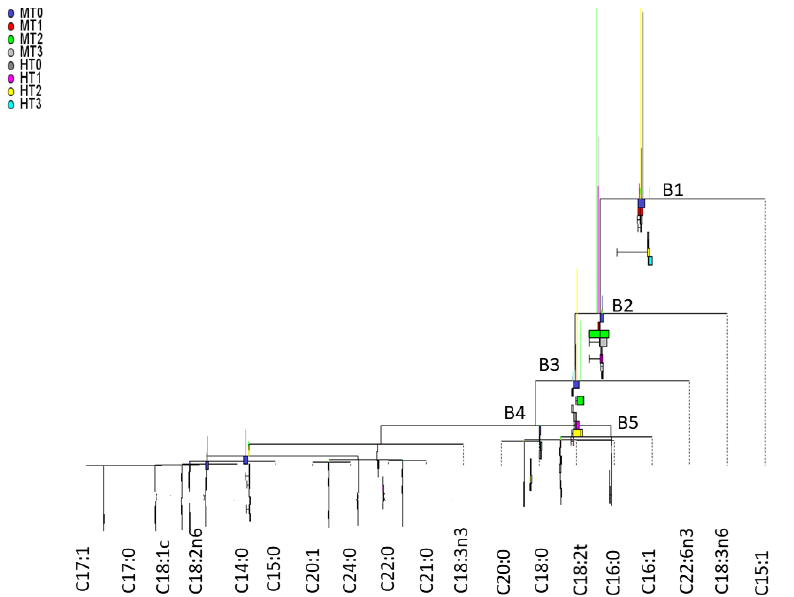
Figure 4. Balance dendrogram, based on the sequential binary partition of parts according to Ward’s clustering ordination. M, Manzanilla; H, Hojiblanca; T0, fresh olives; T1, lye-treated olives; T2, fermented olives; T3, packaged olives. Only the first relevant balances are enumerated.